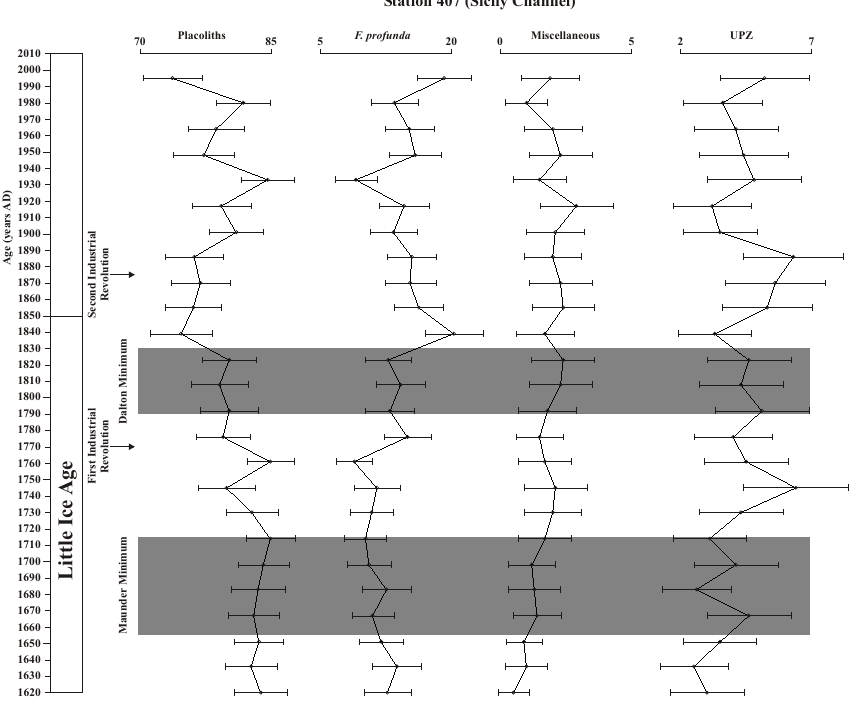
Fig. 6. Distribution patterns of calcareous nannofossil groups (percentage values) at St 407 (Sicily Channel), plotted versus age (years AD). The horizontal bars show the error associated to the countings, for a 95% of confidence level. The top of the Little Ice Age is indicated at 1850 AD, according to (Bradley, 2008; Verschuren and Charman, 2008; Wanner et al., 2008). The Dalton and Maunder Minima are both indicated by gray